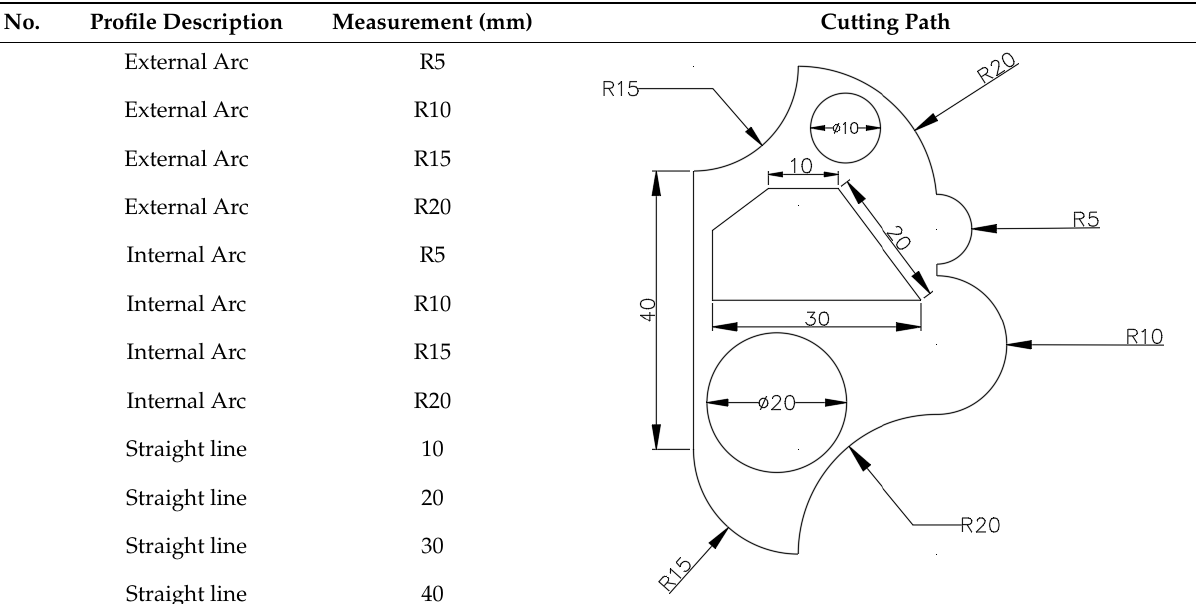
Table 3. AWJ cutting profiles and path.